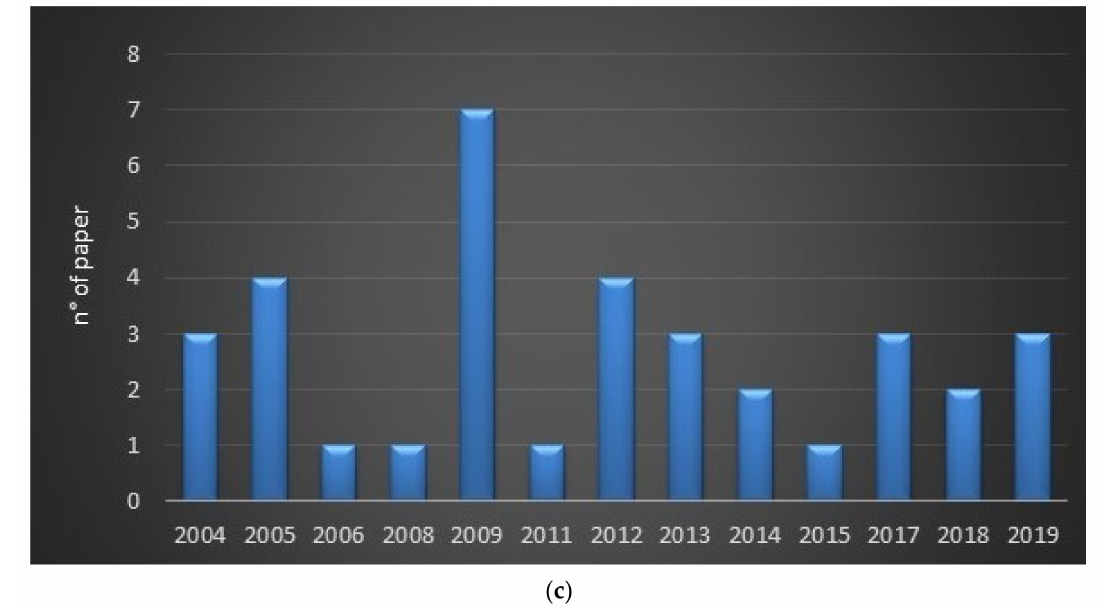
Figure 5. ( a ) Schematic representation of author origin country distribution, ( b ) number of articles per argument (blue indicates the number of pre-clinical studies, red indicates clinical studies), ( c ) distribution of the selected studies by year of